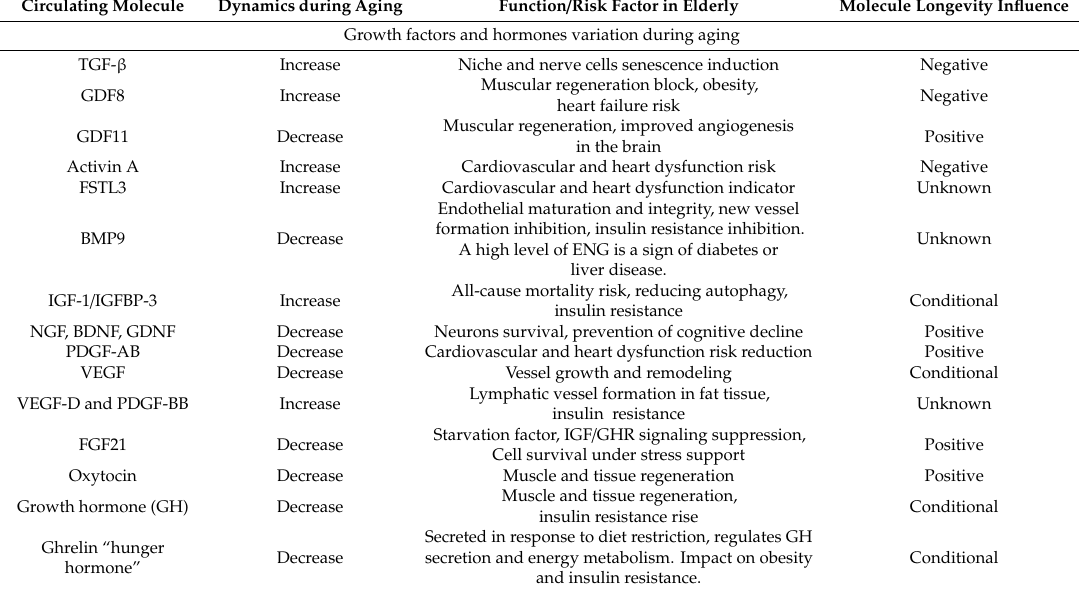
Figure 1. Parabiotic mice model: reciprocal influence of circulation factors on biological aging. In a young organism, the processes of growth and regeneration, high insulin sensitivity, an increased level of cellular cleansing (autophagy, mitophagy) prevail over the processes of accumulation of senescent cells, insulin resistance, catabolism in muscular and other cells, and chronic inflammation (inflammaging) specific for the old organism. Pink arrows indicate factors that are predominantly present in the blood of young animals. The blue arrows show processes and factors – indicators of biological age increase. The parabiotic model with surgically connected vascular system and common blood circulation where factors and cells are exchanged between young and old mice is shown. The model allows assessing the influence of blood factors on biological aging. Several factors shown in the Figure were detected using the parabiotic model (additional description in chapter 3). sVEGF and sICAM1 indicate soluble forms of proteins. “EGF + inflame” shows high levels of EGF signalling combined with high levels of inflammatory factors causing endothelial cell senescence. All names of secreted proteins are explained in the text. We use the names of genes and abbreviations of proteins according to https: // www.genecards.org. Table 2. Dynamics of growth factors, hormones, and inflammatory factors involved in